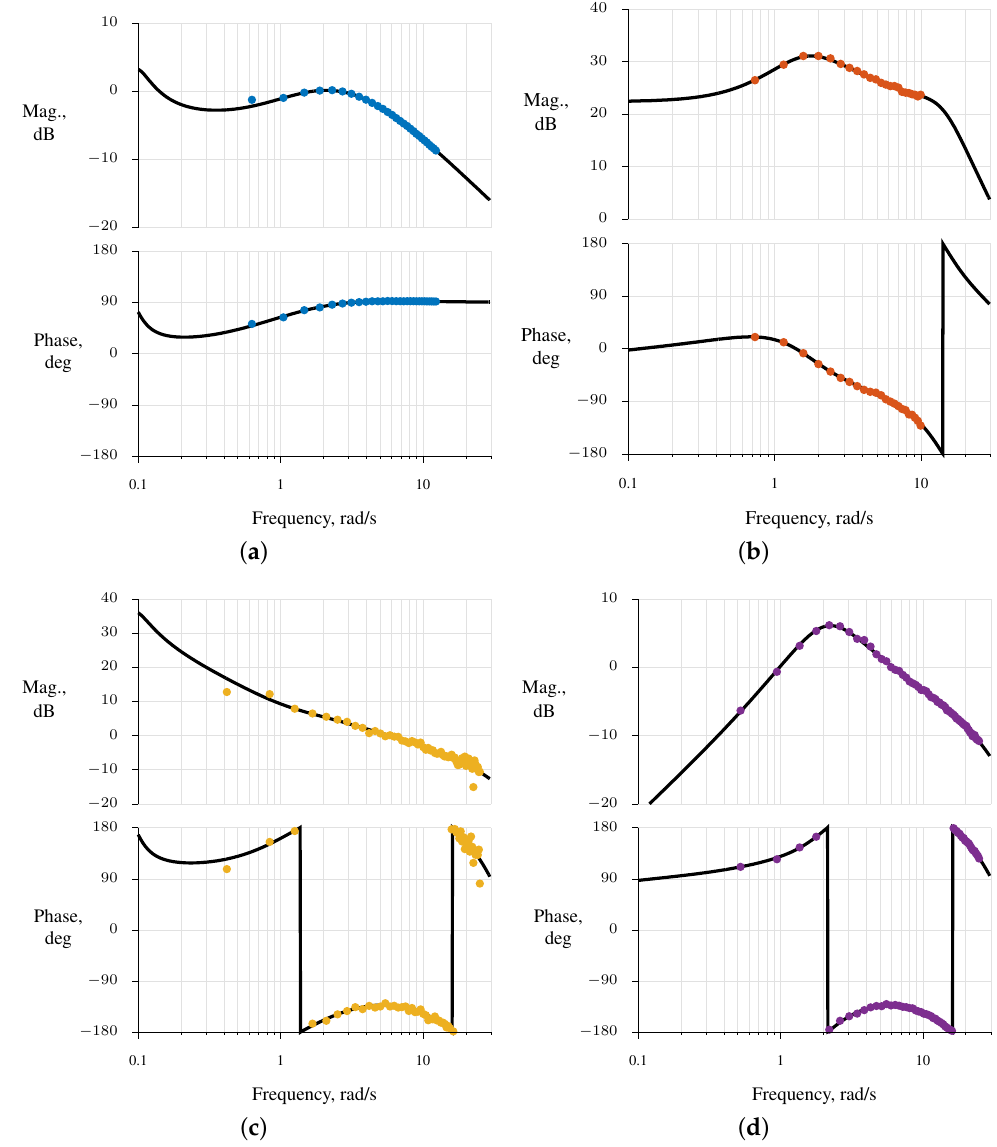
Figure 11. The Bode plots of the true (black lines) and estimated (colored dots) frequency responses for the X-59 example: ( a ) bare-airframe dynamics for symmetric stabilator to pitch rate; ( b ) closed-loop dynamics for pilot longitudinal stick to pitch rate; ( c ) stabilator broken loop; ( d ) pitch rate gyroscope broken